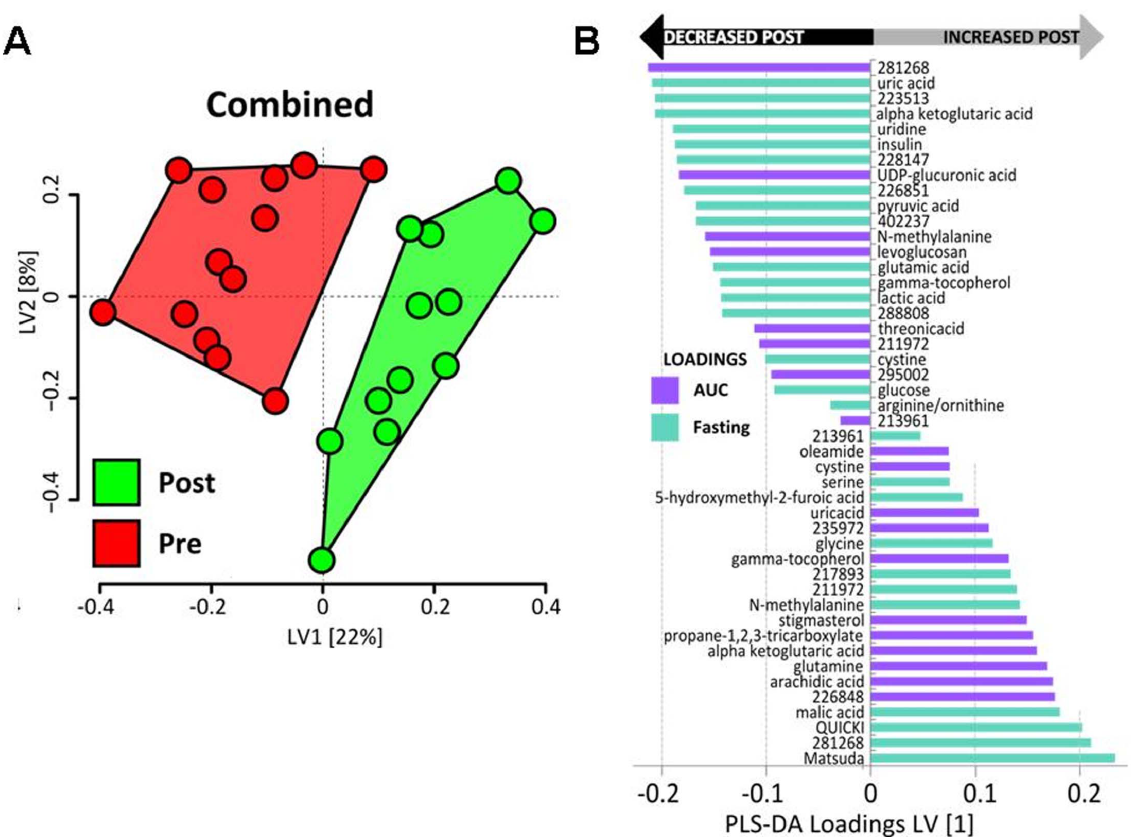
Figure 7. Subject Scores Plot (A) and Variable Loadings Plot (B) derived from a combined PLS-DA model using both overnight- fasted and post-OGTT (area-under-the-curve, AUC) metabolite variances. The model was calculated using a combination of the most robust metabolic features included in separate PLS-DA modeling of the fasted and post-OGTT states (Table 4). Each symbol in the Scores Plot represents the score for a single subject during the pre- or post-intervention phases (red and green, respectively). The best discrimination of phases was evident along the latent variable 1 axis (LV1), and the contribution of individual metabolic phenotype factor variance toward separation of the groups along LV1 is depicted in the Loadings Plot.